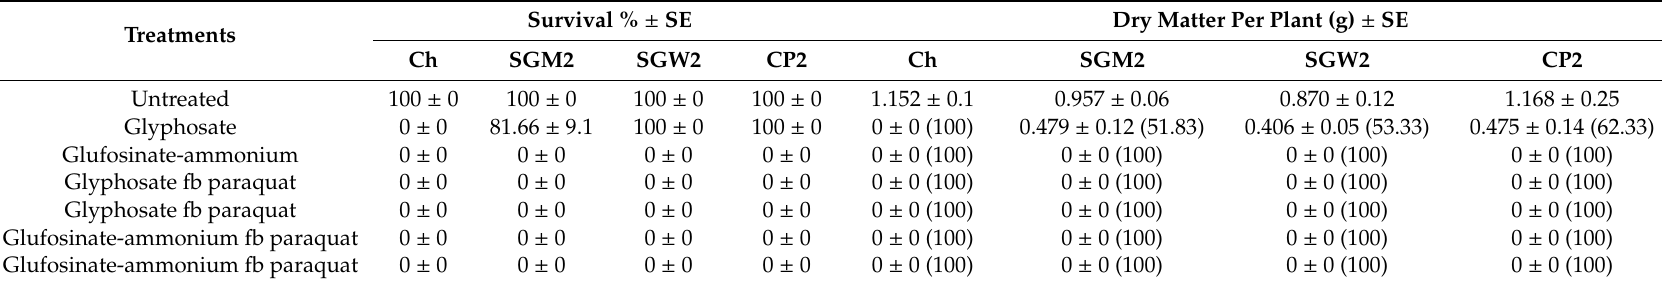
Table 7. E ffi cacy of double knock approach on glyphosate-susceptible (Ch and SGM2) and glyphosate-resistant (SGW2 and CP2) biotypes after 28 days.